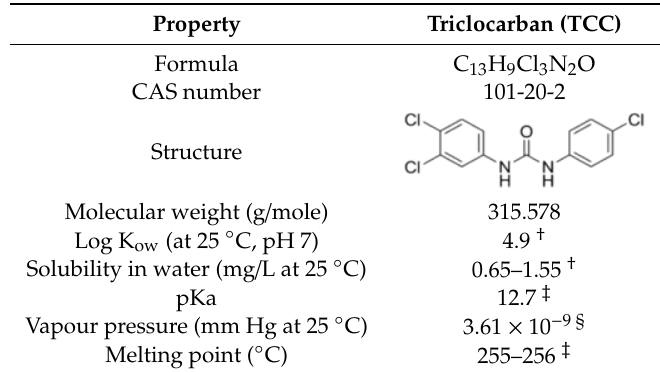
Table 3. Key physicochemical properties of triclocarban.